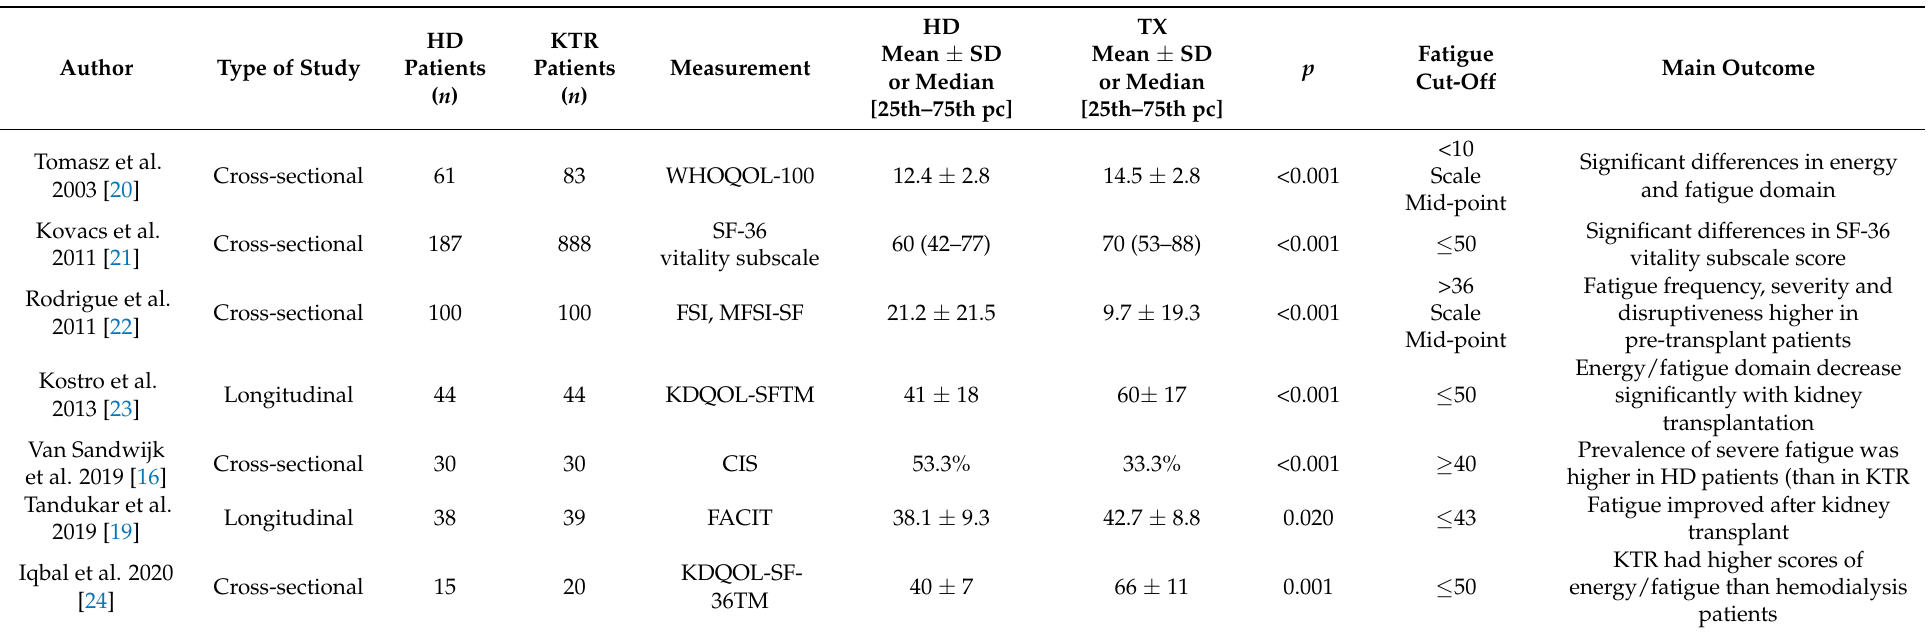
Table 1. Comparison of fatigue between patients on chronic hemodialysis and kidney transplant recipients. CIS, Checklist Individual Strength; FACIT-F, Functional Assessment of